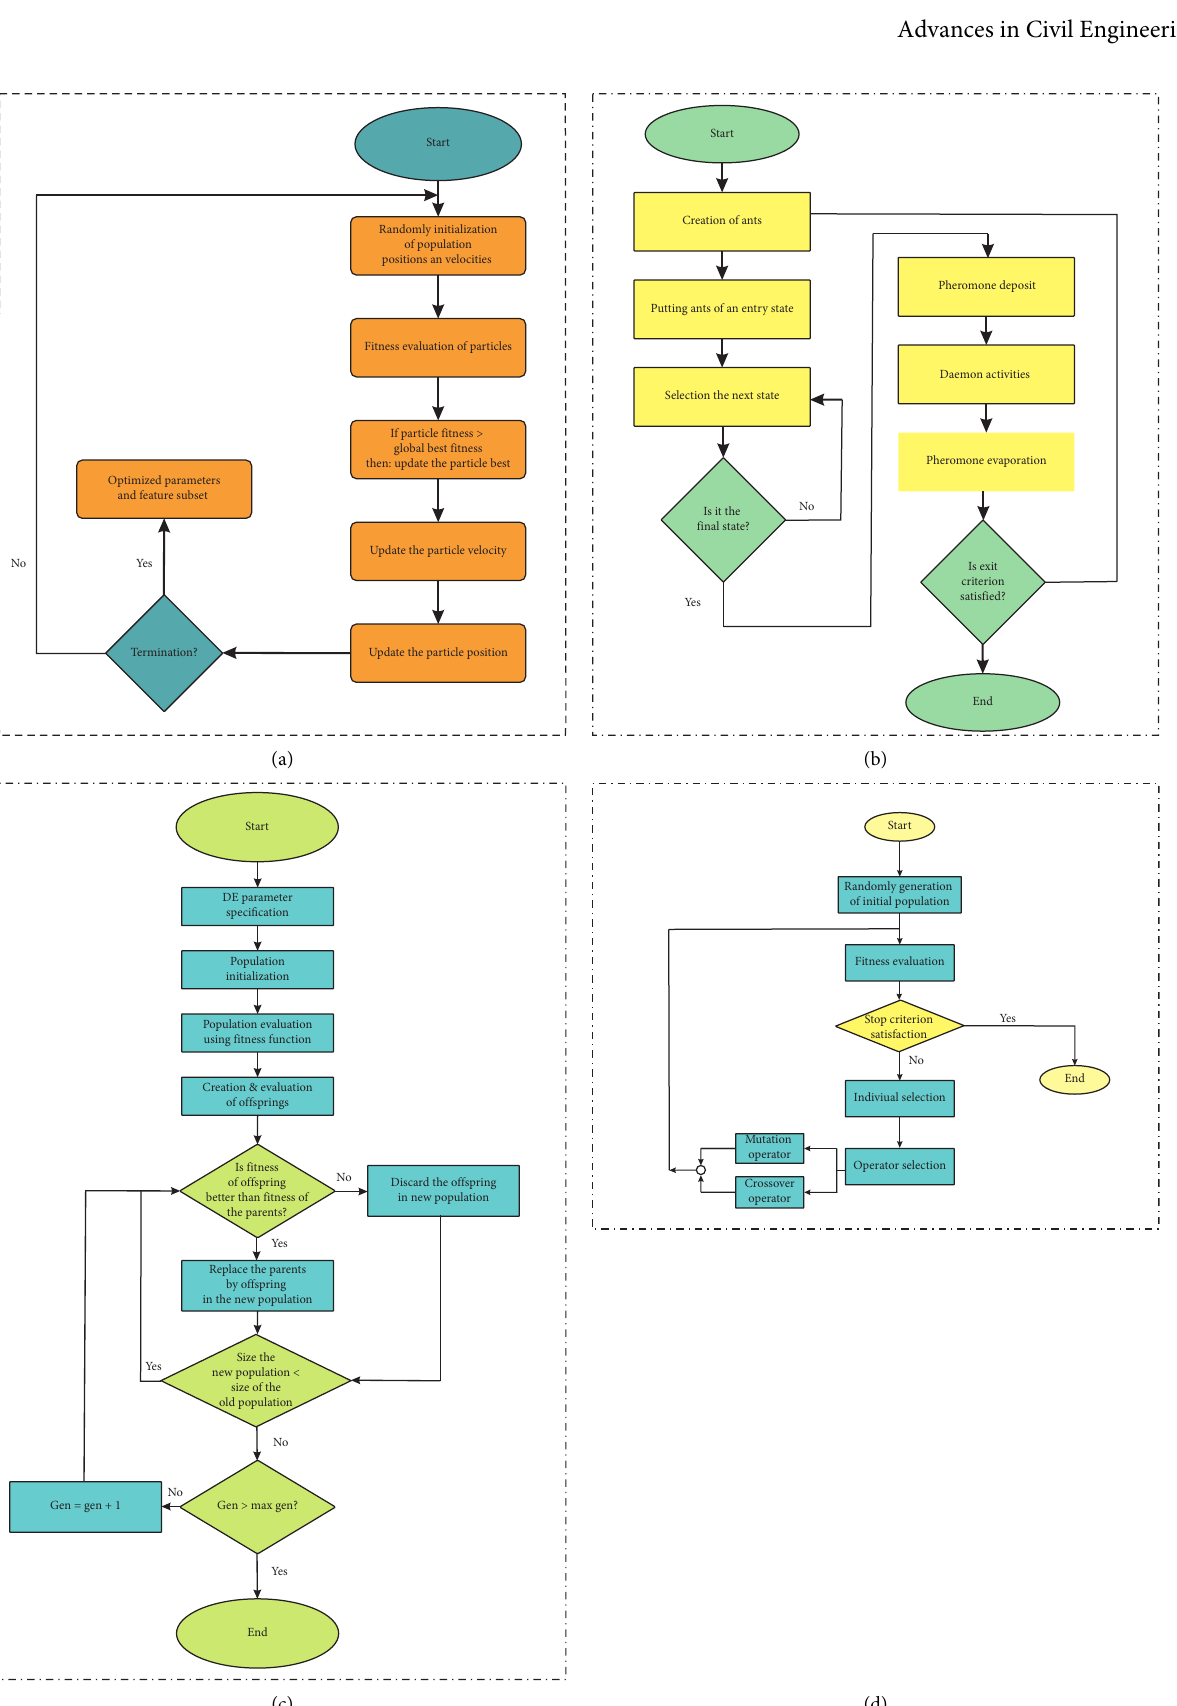
Figure 3: (a) Functional flowchart of PSO algorithm, (b) functional flowchart of ACO algorithm, (c) typical flowchart of DE algorithm, and (d) flowchart of genetic